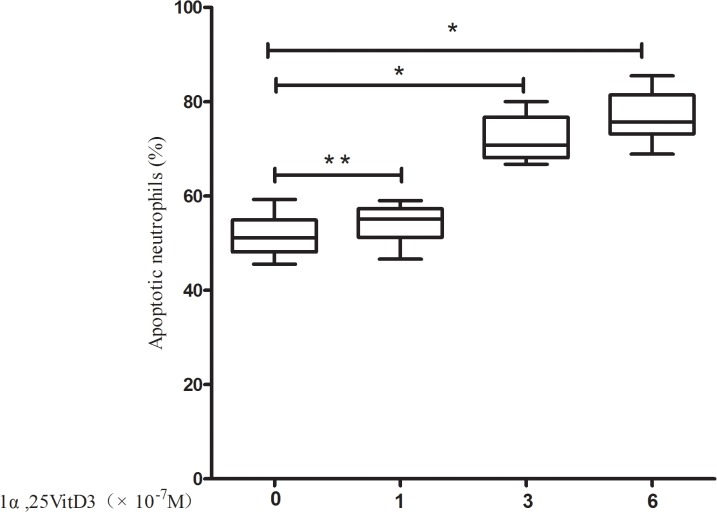
1α,25VitD3 induced peripheral blood neutrophil apoptosis in a dose-dependent manner in the AECOPD patients.Neutrophils were cultured for 24 h in the absence or presence of 1×10–7 M, 3 ×10–7 M or 6 ×10–7 M 1α,25VitD3 as indicated, and then assessed for apoptosis of neutrophils by flow cytometry. The data are presented as the means±sd, n = 6, *P < 0.05, **P > 0.05.